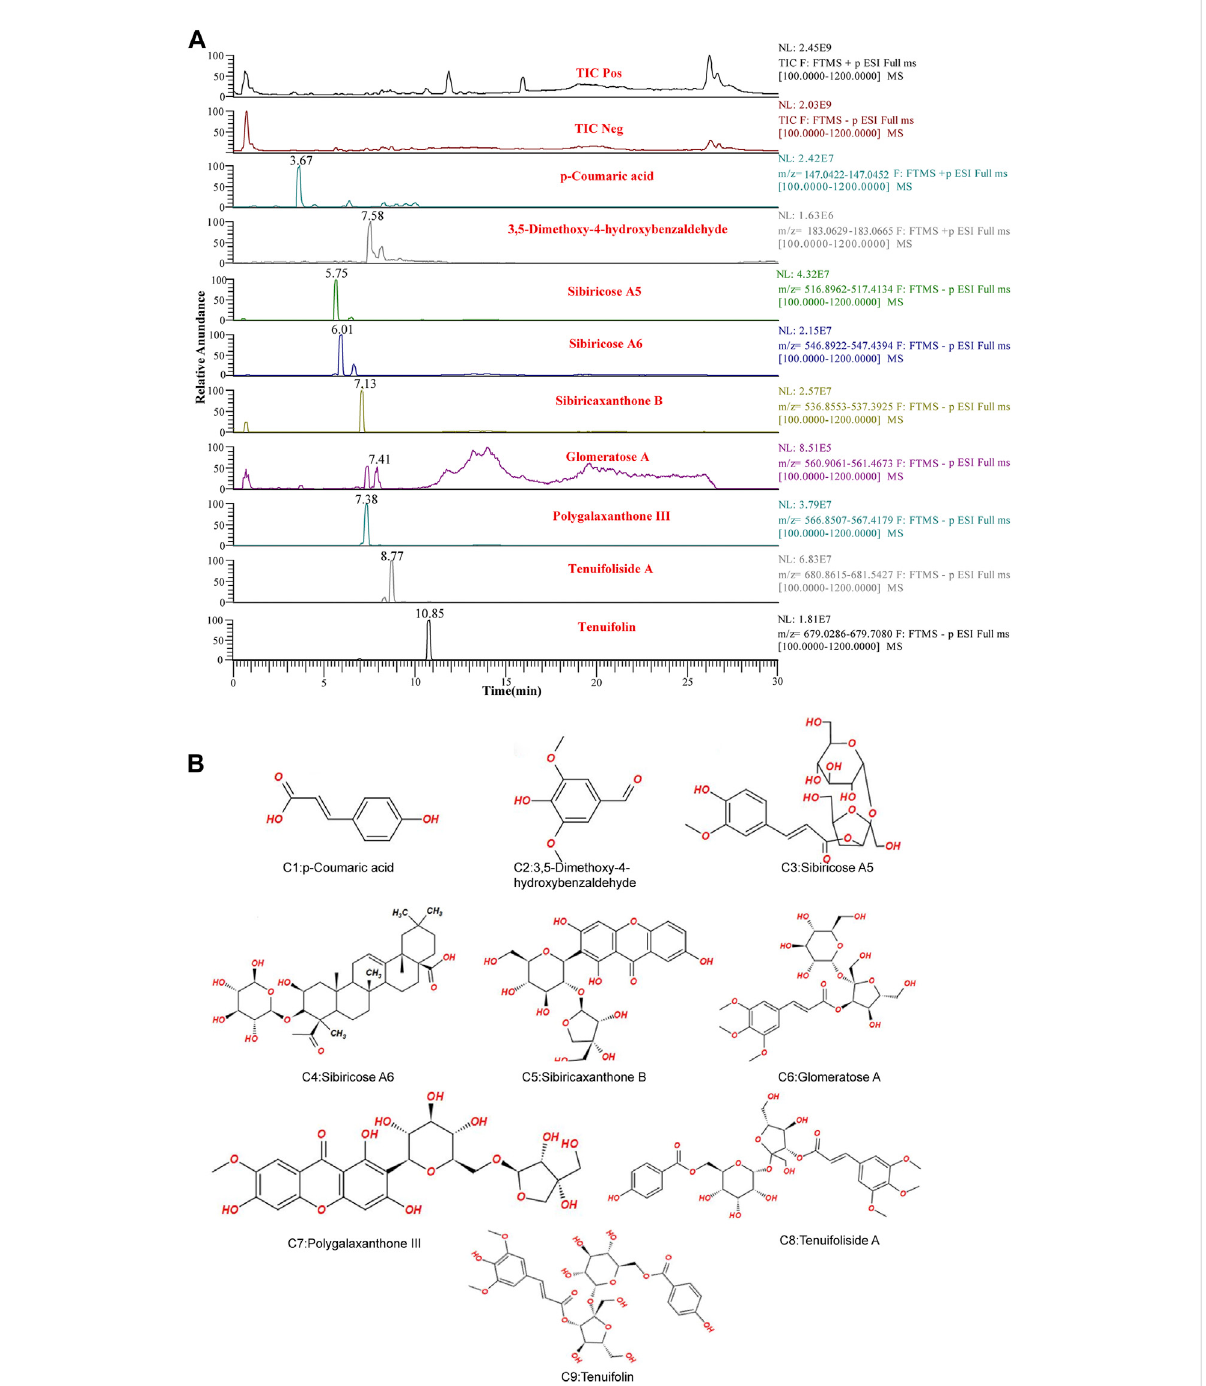
FIGURE 3 UPLC-LTQ-Orbitrap-MS spectrometry of SCPE serum characteristic compounds. (A) Total ion chromatogram (TIC) and selected ion chromatogram (SIC) of SCPE in fl uent sample. Stationary Phase: ACQUITY UPLCTM HSS T3 (100 mm × 2.1 mm, 1.8 μ m); Mobile phase: Solvents A (0.1% formic acid-water) and B (1% formic acid-acetonitrile). Optimized gradient elution program: 0 – 3.5 in, 0% – 15% B; 3.5 – 6 min, 15% – 30%B; 6 – 12 min, 30% – 70% B; 12 – 12.5 min, 30% – 70% B; 12.5 – 18 min, 100% B; Flow rate: 0.4 ml/min (Peak number: Rt,3.67 min, p-Coumaric acid; 7.58 min, 3,5-Dimethoxy-4-hydroxybenzaldehyde; 5.75 min, Sibiricose A5; 6.01 min, Sibiricose A6; 7.13 min, Sibiricaxanthone B; 7.41